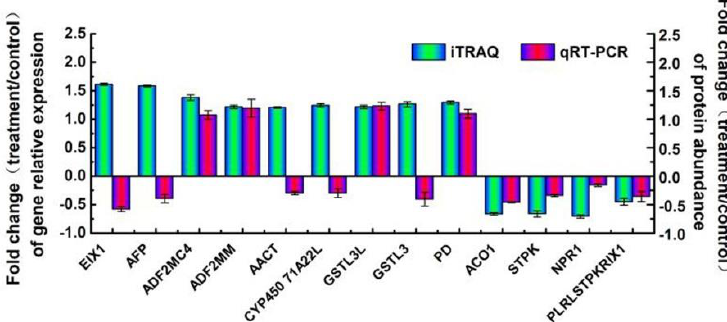
Figure 10. Correlation of mRNA level and protein abundance by iTRAQ. The fold-change of treatment/control in transcript level using the qRT-PCR approach of 19 candidate genes involved in the identified proteins with differential abundance and the protein abundance level by iTRAQ is shown in the figure. The positive number indicates increased abundance, and the negative number indicates decreased abundance. Each histogram represents the mean value of three biological replicates, and the vertical bars indicate the standard error ( n = 3). Definition of 19 candidate genes involved in the identified proteins with differential abundance: EIX1, esterase isoform x1; AFP, amidase family protein; ADF2MC4, aldehyde dehydrogenase family 2 member c4; ADF2MM, aldehyde dehydrogenase family 2 member mitochondrial; AACT, acetyl-CoA c-acetyltransferase 3; CYP 71A22L, cytochrome p450 71a22-like; GSTL3L, glutathione s-transferase l3-like; GSTL3, glutathione s-transferase l3; PD, phytanoyl-dioxygenase; ACO1,1-aminocyclopropane-1-carboxylate oxidase 1; STPK, serine threonine-protein kinase; NPR1, regulatory protein NPR1; PLRLSTPKRIX1, probable lrr receptor-like serine threonine-protein kinase rfk1 isoform x1.